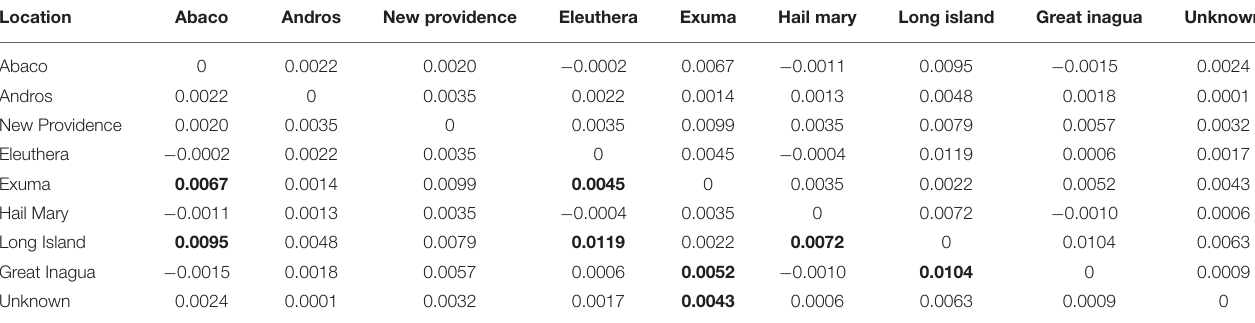
TABLE 3 | Results of Nassau grouper population differentiation within The Bahamas based on pairwise F ST values. Location Abaco Andros New providence Eleuthera Exuma Hail mary Long island Great inagua